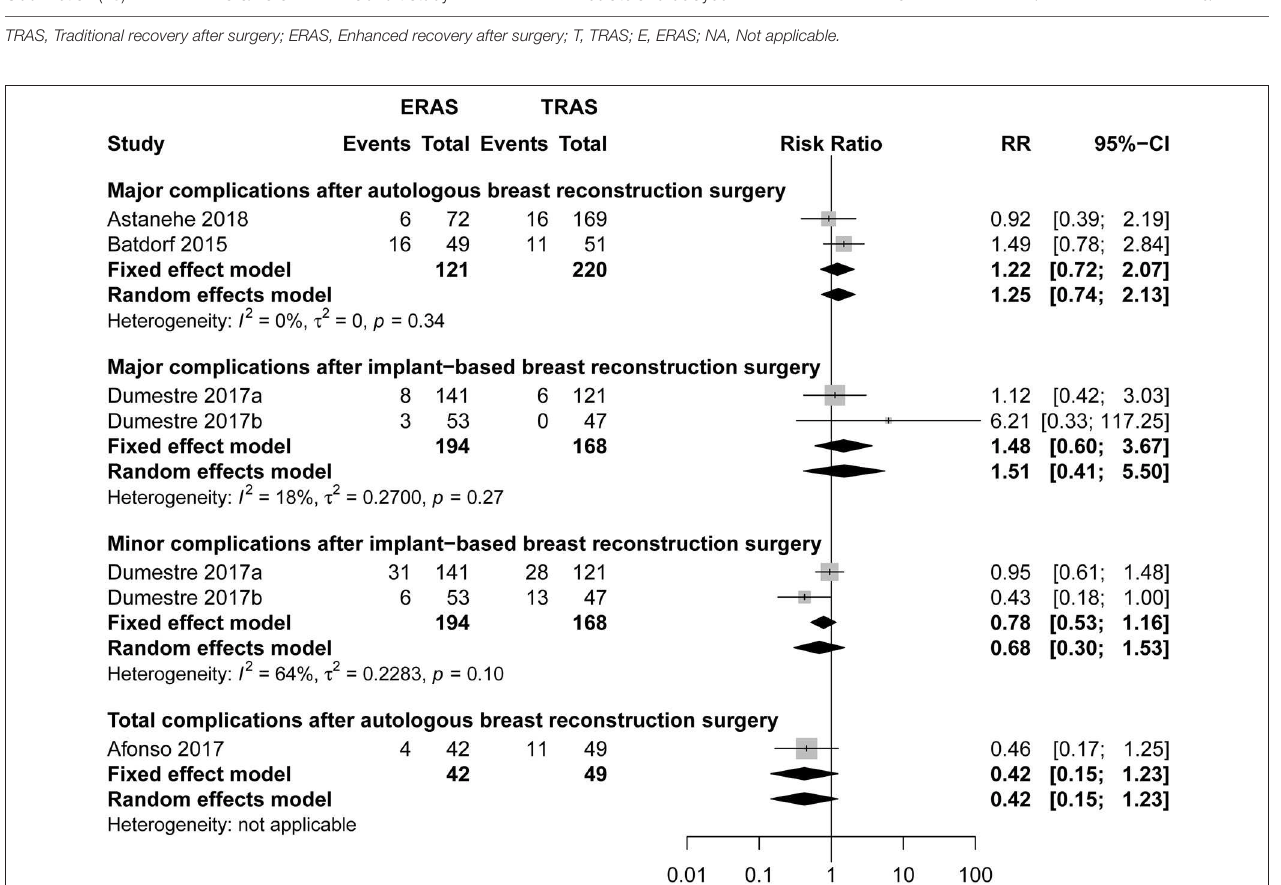
systemic ( Figure 4 ), or opioid-related ( Table 3 ; RR, 0.57; 95% CI, 0.28–1.16; I 2 = 41%) complications and urinary tract infection ( Figure 4 ; RR, 0.38; 95% CI, 0.06–2.28; I 2 = 0%) within 30 days after